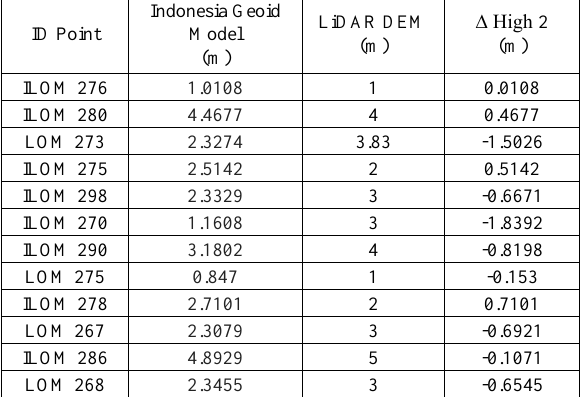
Table 3. Differences high value between LiDAR DEM and